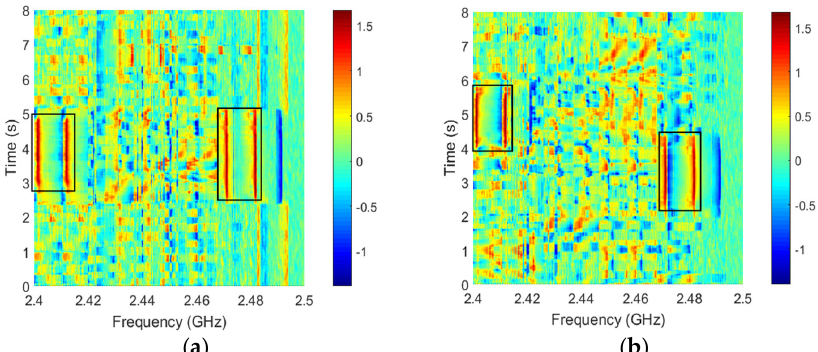
Figure 25. The results for the improved cross-correlation method for two UAVs indoors at distances of ( a ) 5 m and ( b ) 10 m.